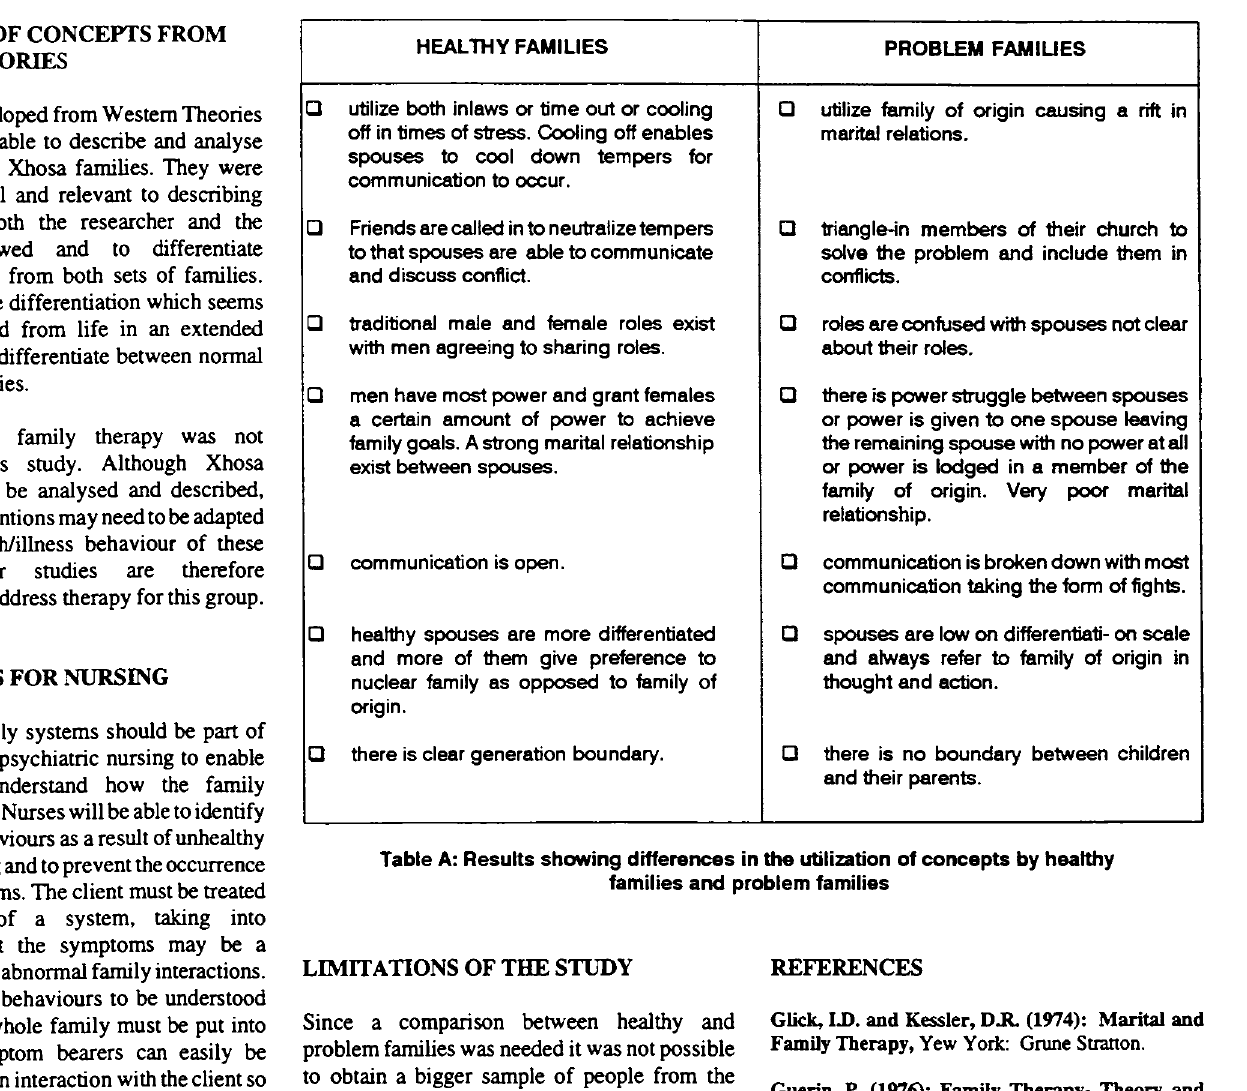
LIMITATIONS OF THE